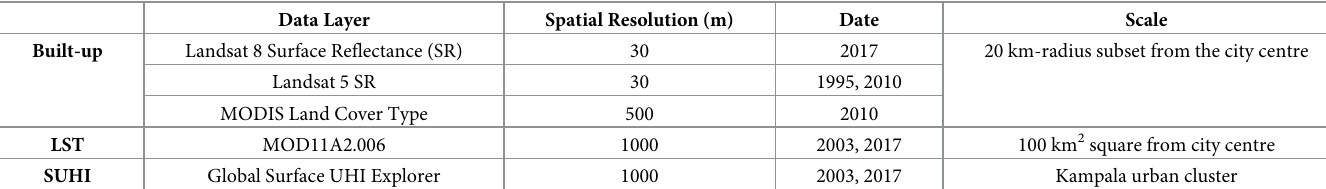
Table 1. Data sources used to examine historical patterns of urbanisation in Kampala,